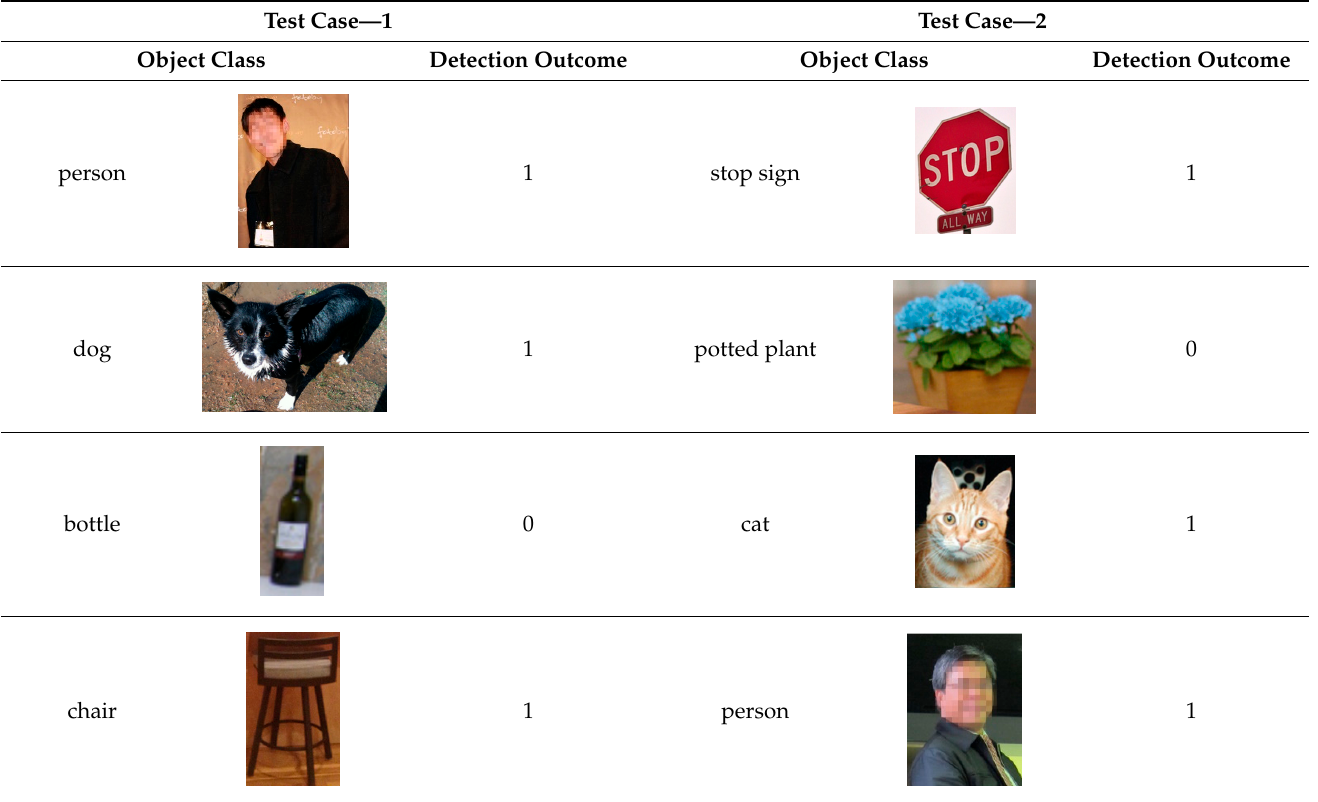
Table 3. Sample detection outcome for test cases 1 and 2 (where 1 = known and 0 = unknown).